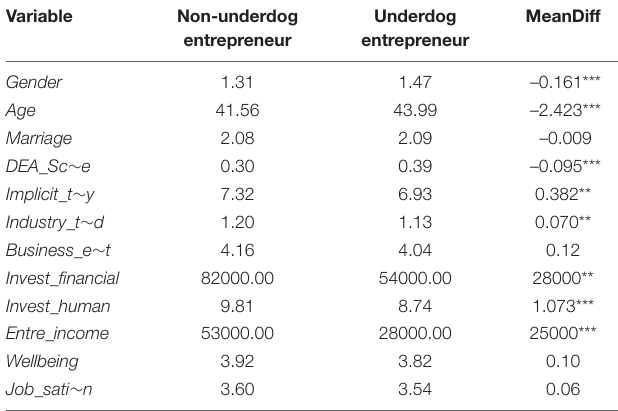
TABLE 3 | Characteristics of underdog entrepreneurs and non-underdog